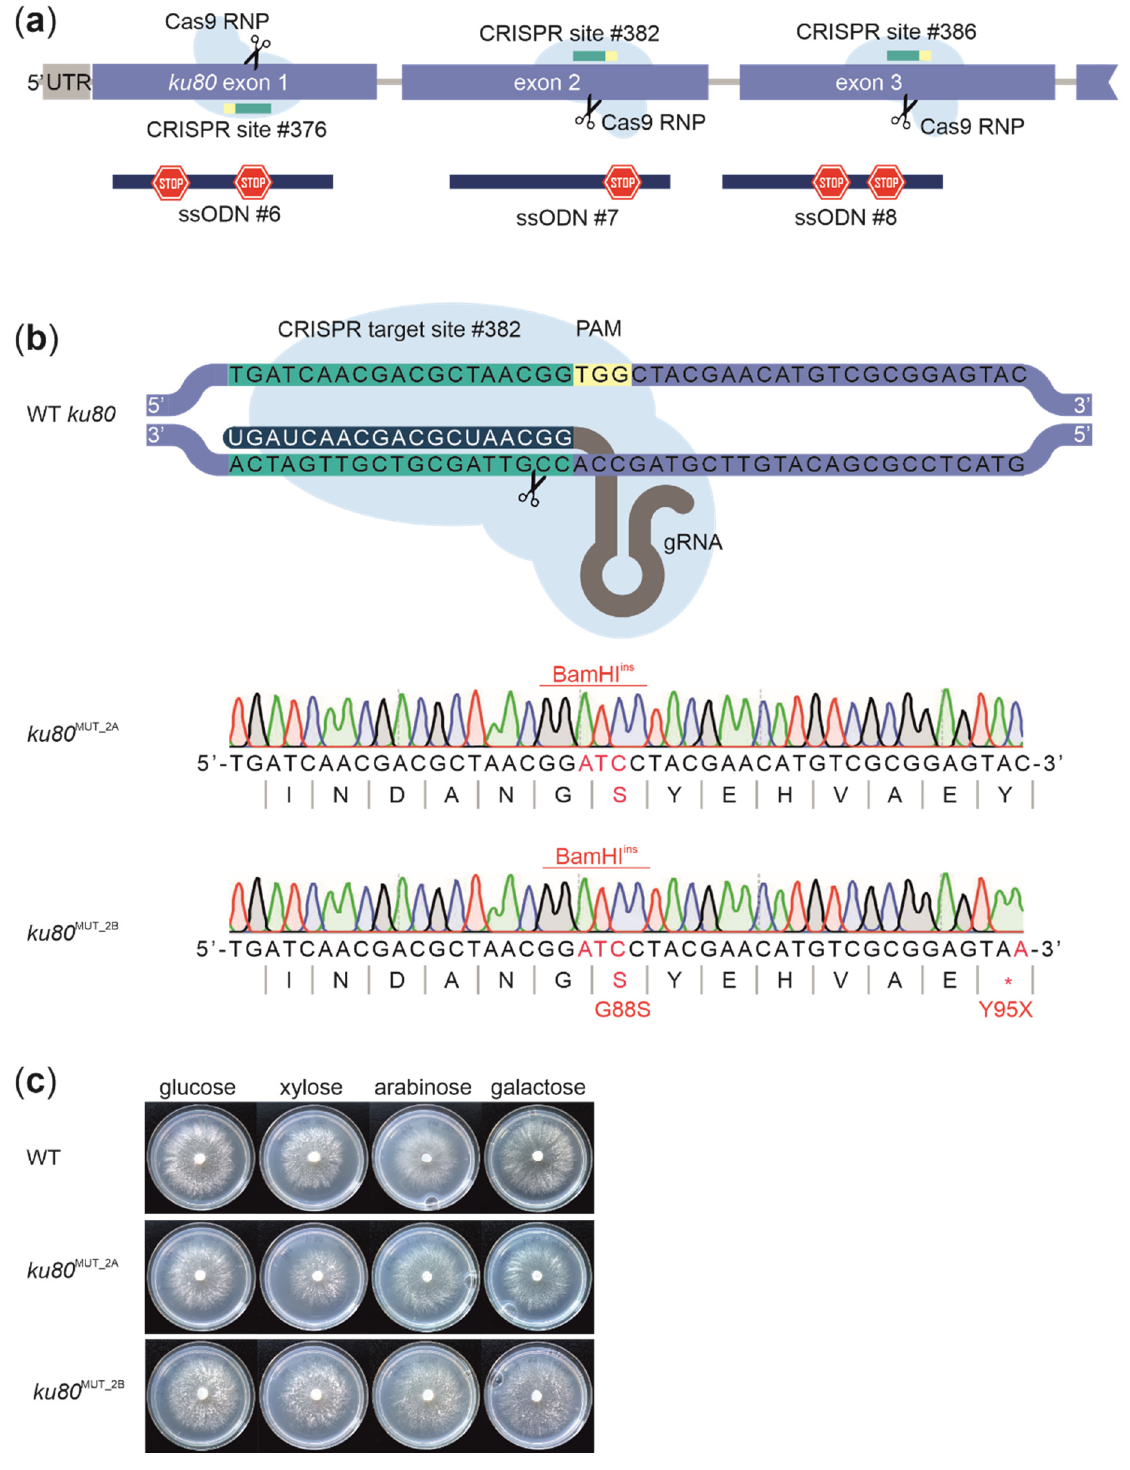
Figure 4. ( a ) The first, second or third exon of the D. squalens ku80 gene were targeted for introduction of STOP codon(s) (*). ( b ) Schematic representation of the Cas9 target site in the second exon of the ku80 gene of the wild-type D. squalens (WT); obtained edits in ku80 MUT_2A and ku80 MUT_2B strains are shown. ( c ) The ku80 MUT_2A and ku80 MUT_2B mutants are phenotypically indistinguishable from the WT.